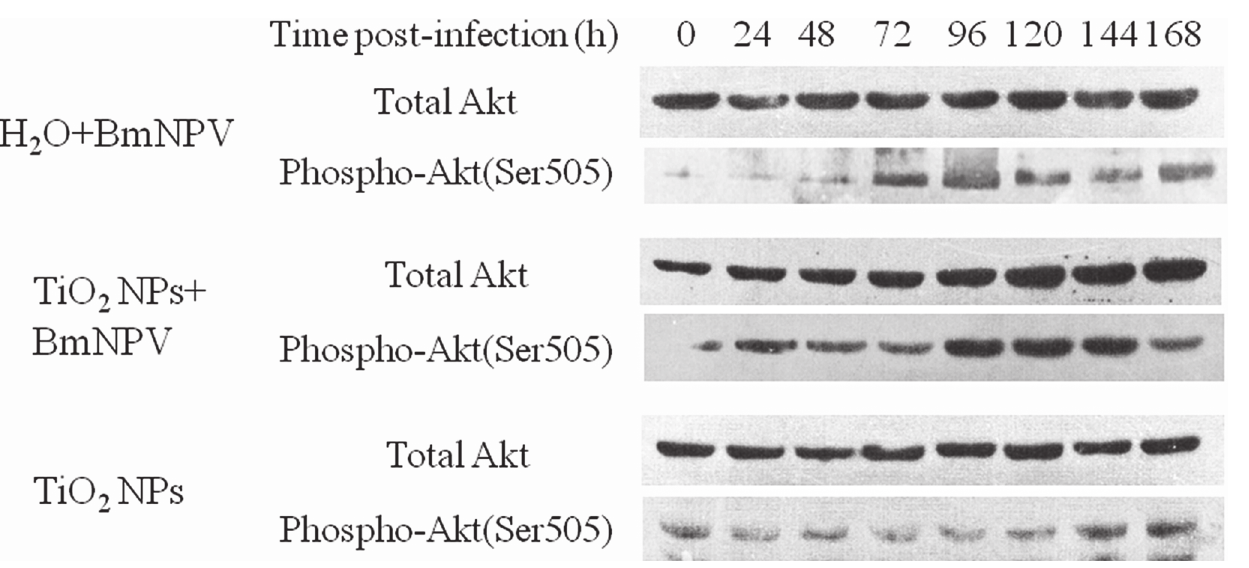
Fig 10. BmNPV infection and TiO 2 NPs activate Akt phosphorylation. Fat body lysates isolated at the designated time points after infection were subjected to western blot analysis using a total Akt-specific or phospho-Akt (Ser 505) antibody.